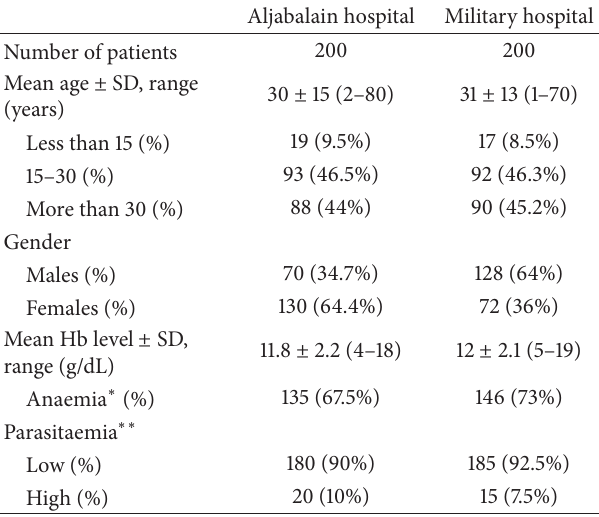
Table 1: The mean age, gender and haemoglobin level in Aljabalain hospital and military